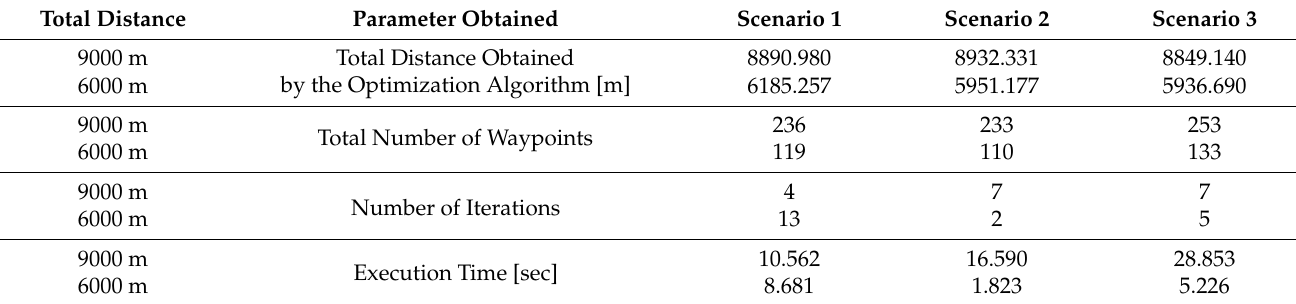
Table 3. Average results from the variation of total distances for path planning.